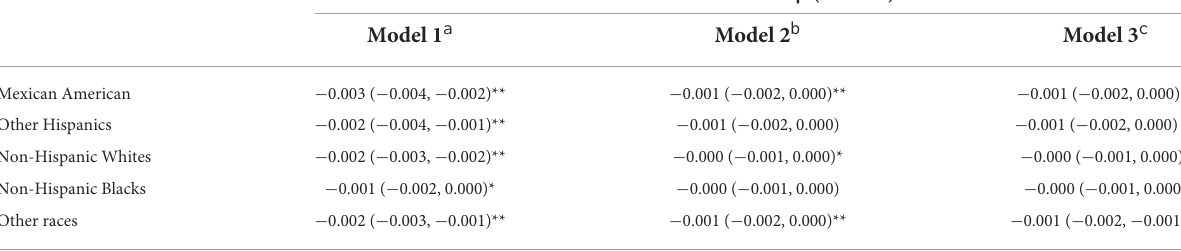
TABLE 4 Linear regression relationship for serum vitamin D and log-transformed HOMA-IR in stratification analysis of